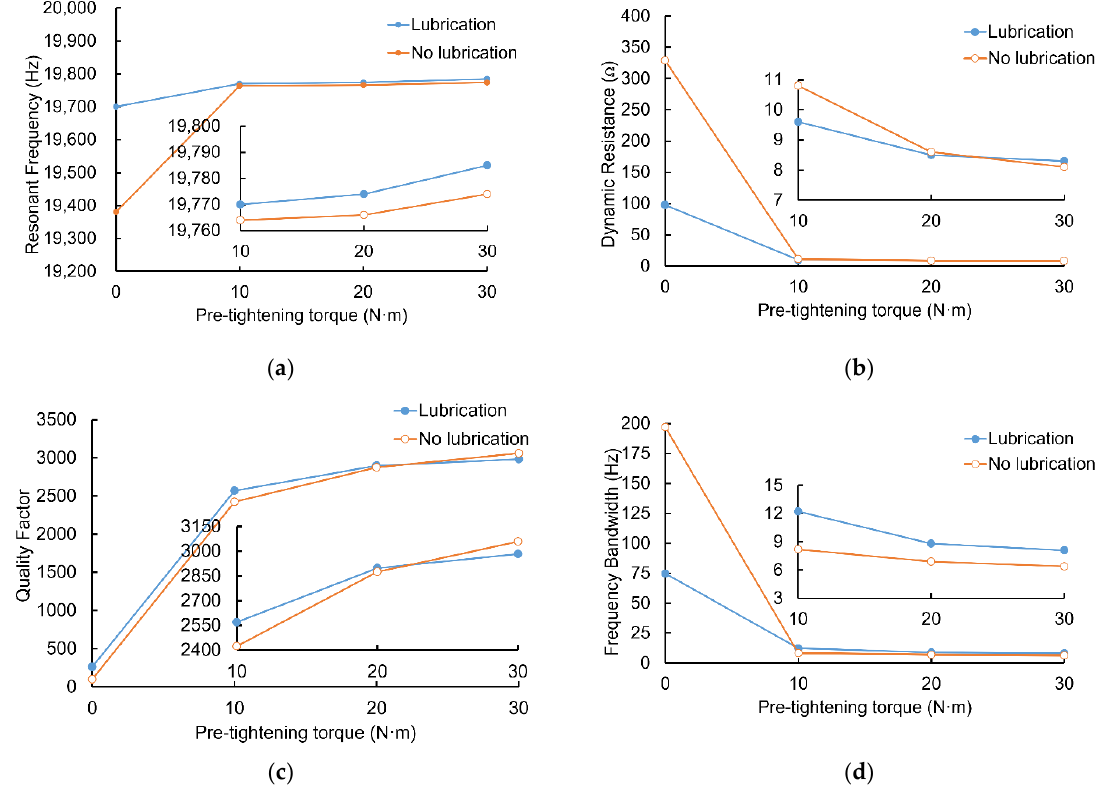
Figure 8. Influence of the tool (straight edge knife) assembly parameters on static performance parameters. ( a ) Influence of pre-tightening torque of the tool junction surface on resonance frequency. ( b ) Influence of pre-tightening torque of the tool junction surface on dynamic resistance. ( c ) Influence of pre-tightening torque of the tool junction surface on quality factor. ( d ) Influence of pre-tightening torque of the tool junction surface on frequency bandwidth.